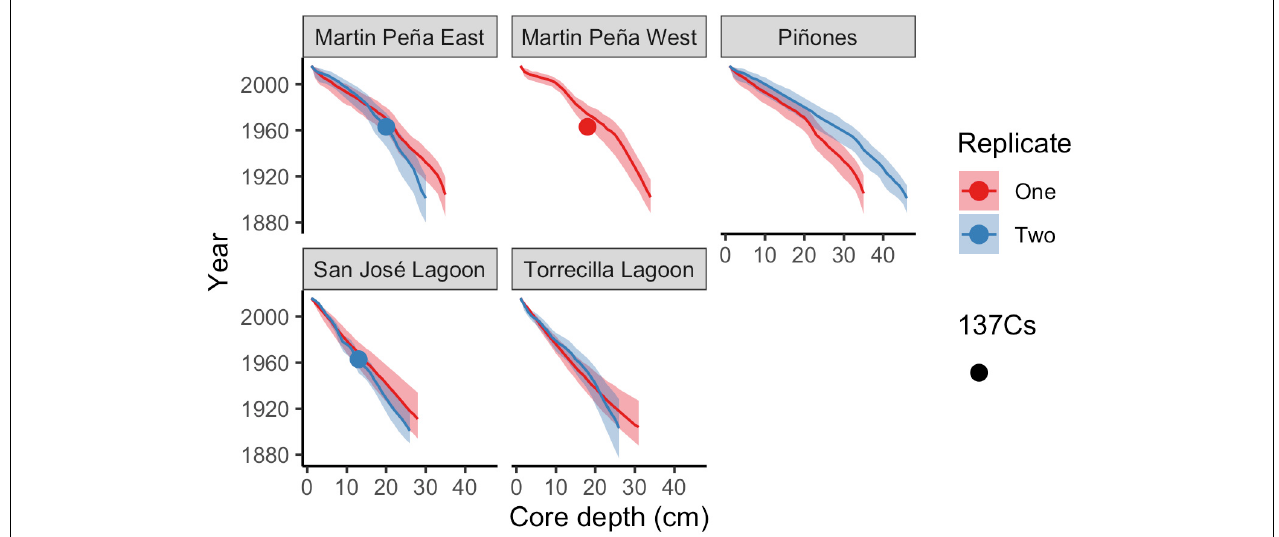
FIGURE 2 | Core age-depth profiles using the Plum model (Aquino-López et al., 2018) estimated sediment year with depth in each core. Means (solid line) and 95% confidence intervals are depicted for each core. Cores with detectable 137 Cs peaks are indicated with circles.